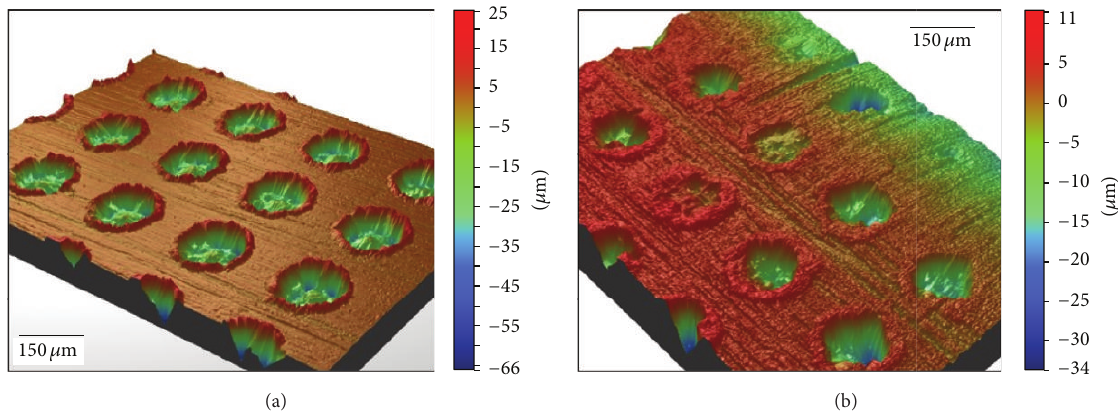
Figure 10: Surface topography—texture #4, die radius: (a) before and (b) after the stamping tests.